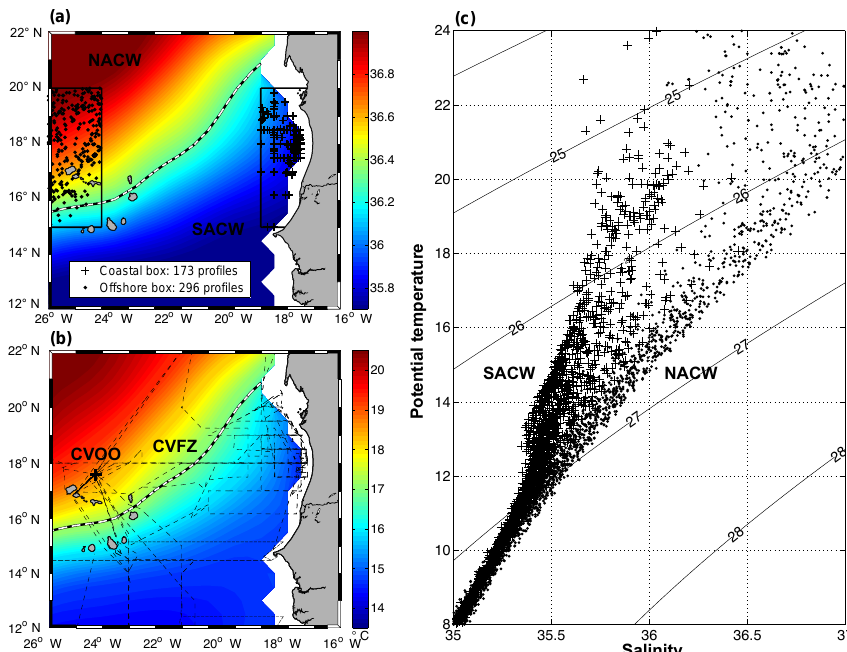
Figure 2. Mean salinity (a) and potential temperature (b) at 100m depth in the TANWA from the monthly, isopycnal/mixed-layer ocean (MIMOC) climatology (Schmidtko et al., 2013) and θ/S diagram (c) . The thick black/white line in (a) and (b) indicates the CVFZ. In (a) crosses and dots represent all available profiles (from Argo floats and ships) in the marked coastal and offshore boxes, respectively. In (c) , the thin dashed line mark cruise tracks of 20 research cruises to the TANWA taking profiles used in the present study. The black cross in (b) indicates the position of the Cape Verde Ocean Observatory (CVOO) mooring. In (c) data from the coastal and offshore boxes are marked by crosses and dots, respectively; superimposed are isolines of potential